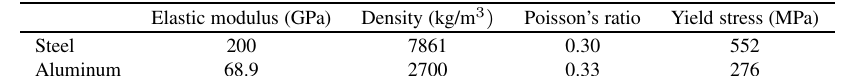
Table 5 Nominal material properties used in finite element model